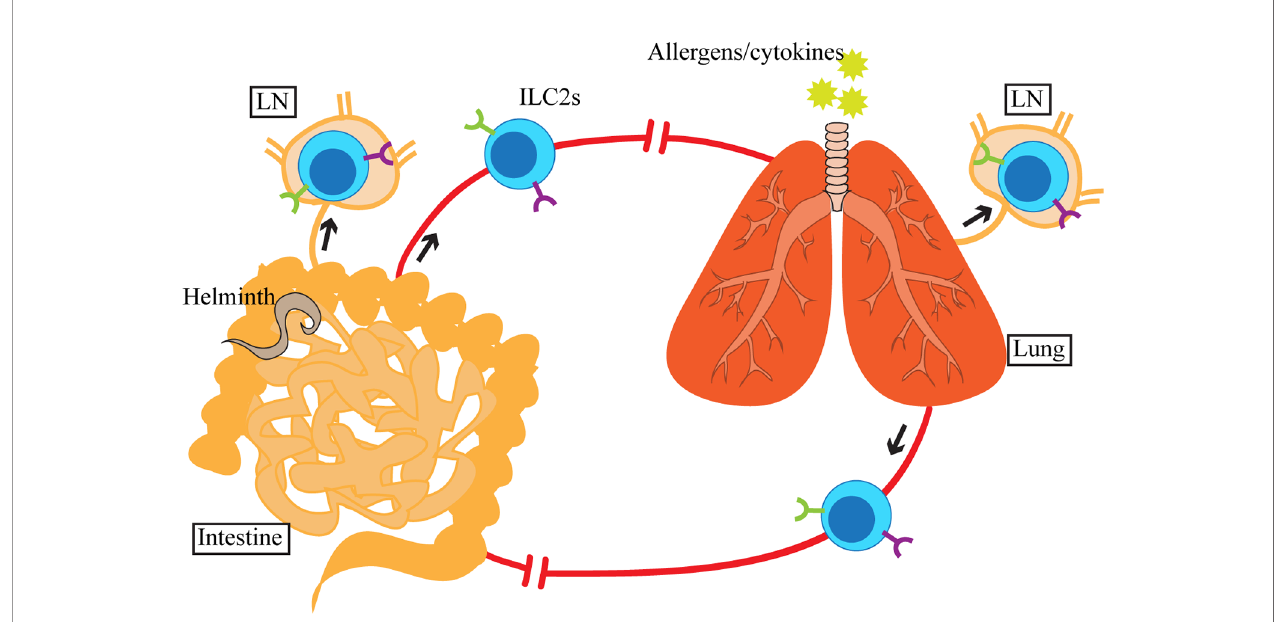
FIGURE 2 | Upon activation by allergens, cytokines or helminths in the lung or small intestine (SI), ILC2s and in fl ammatory ILC2s (iILC2s) appear in circulation as well as in the tissue-draining lymph nodes (LN). SI-derived iILC2s migrate to the lung, whereas the destination of activated SI and lung ILC2s is currently unclear. Although ILC2s and iILC2s are detected in blood and LN, which suggests that their migration involves lymphatics and blood, the exact route of migration has yet to be